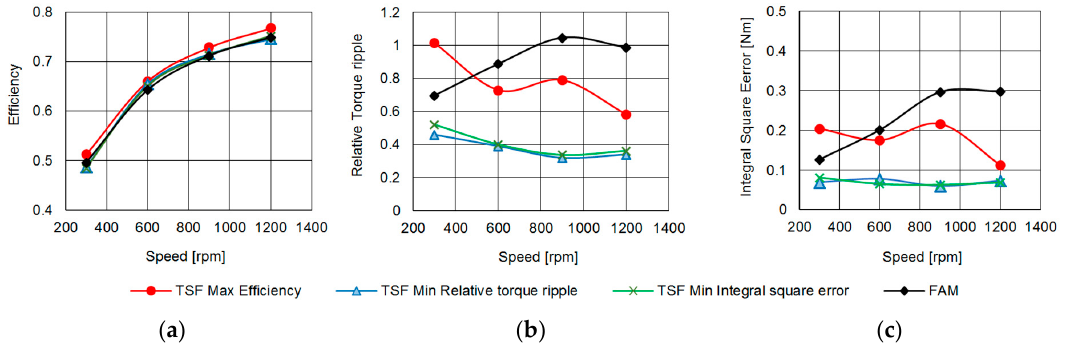
Figure 11. Comparison of the firing angle modulation (FAM) method and TSF at load torque 1 Nm: ( a ) efficiency; ( b ) relative torque ripple; ( c ) integral square error.